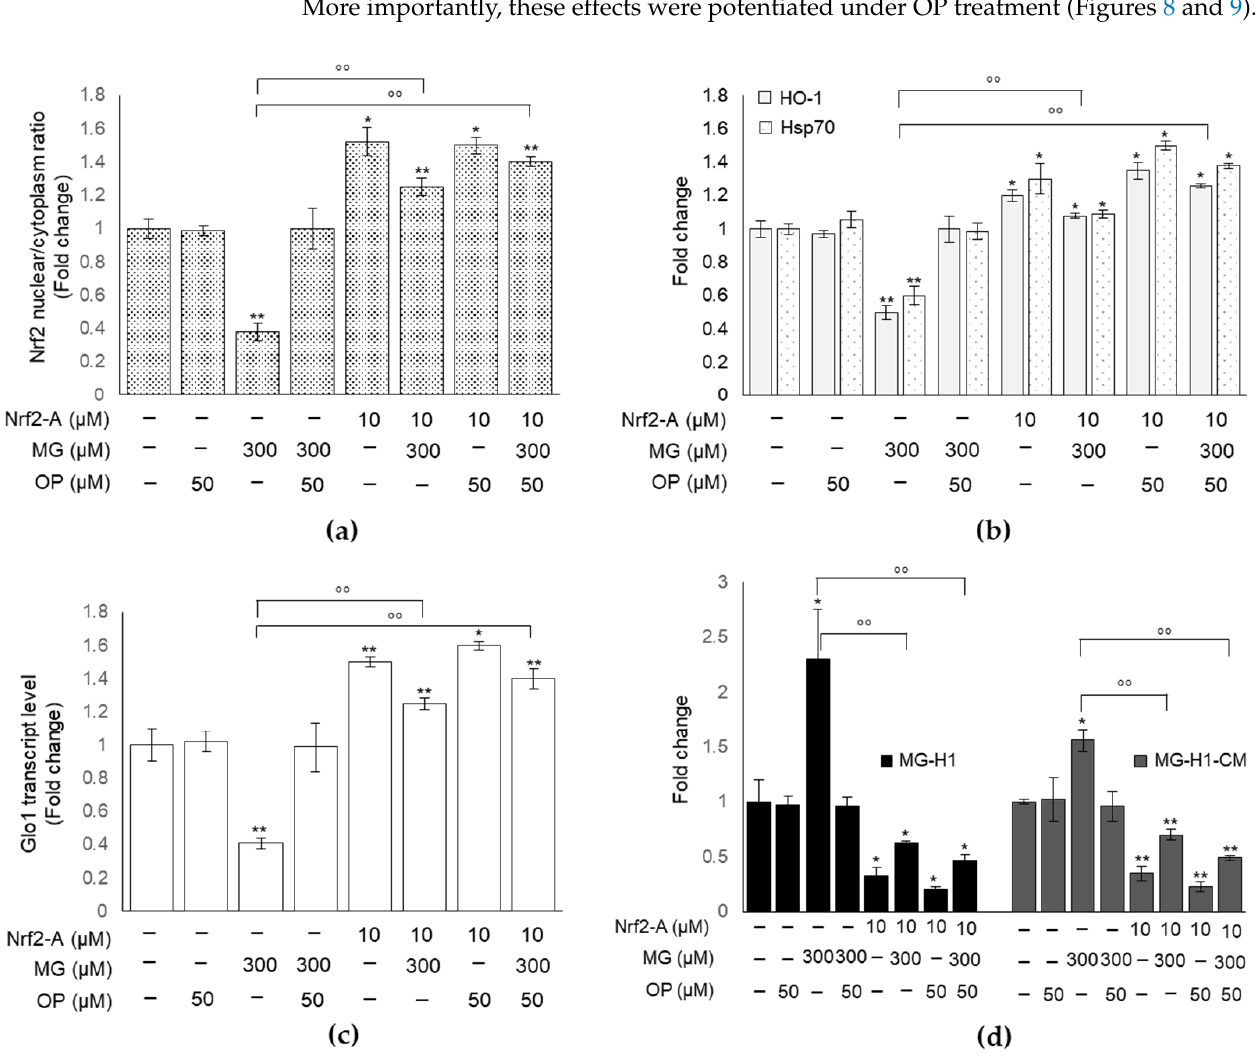
Figure 8. MG-induced responses and OP prevention through Nrf2/Glo1 axis in DPSCs. ( a , b ) Nrf2 activation resulted in ( c ) a significant rescue of Glo1 expression and reduction in ( d ) MG-H1 intracellular and released levels (MG-H1-CM). Histograms indicate the means ± SD of three different cultures, each of which was tested in triplicate. * p < 0.05, ** p < 0.01 versus unexposed cells; ◦◦ p < 0.01, versus MG-treated